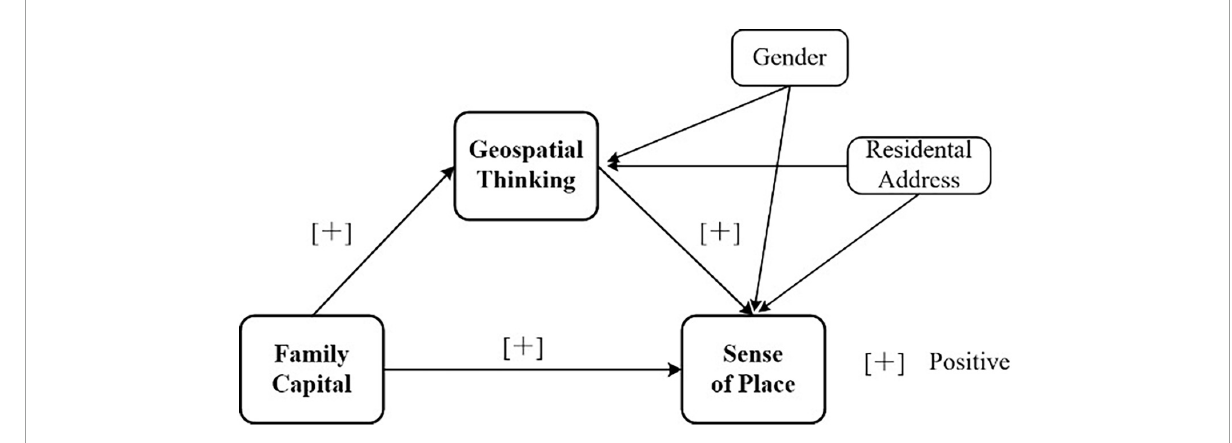
FIGURE1 Relationships examined in the